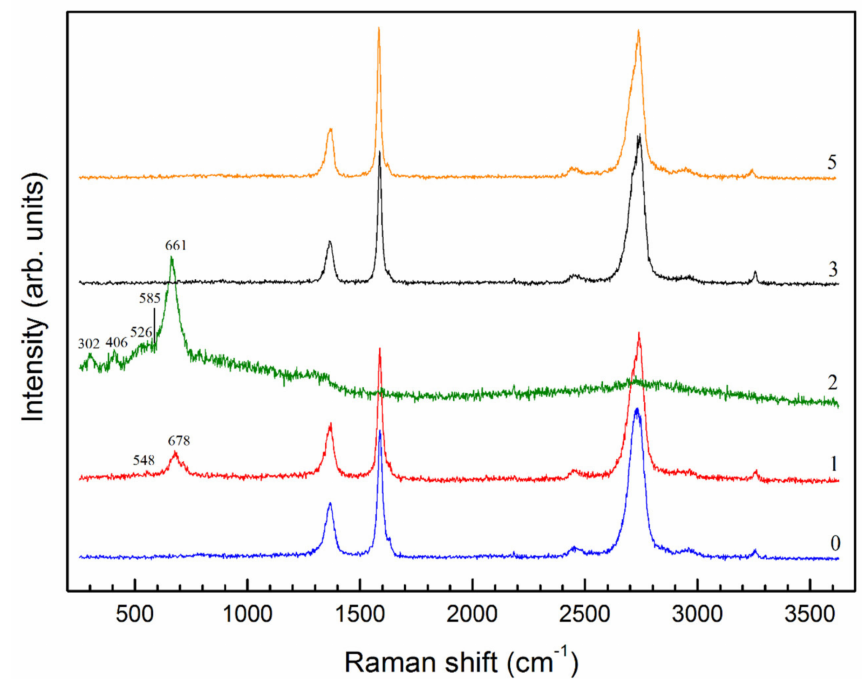
Figure 4. The Raman spectra of the samples: 0—pure iron carbide Fe 3 C; 1–5—solid products of the chemical reaction between Fe 3 C and H 2 O: at 873 K and 2.5 GPa (exp. #1); at 1023 K and 2.5 GPa (exp. #2), at 1023 K and 3.5 GPa (exp. #3), at 1123 K and 4.5 GPa (exp.